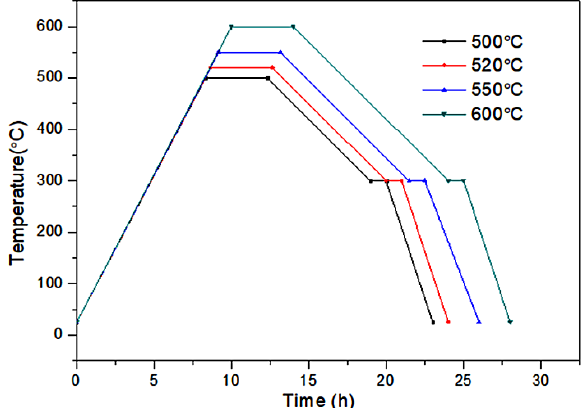
Figure 1. The temperature steps of the sintering cycles.